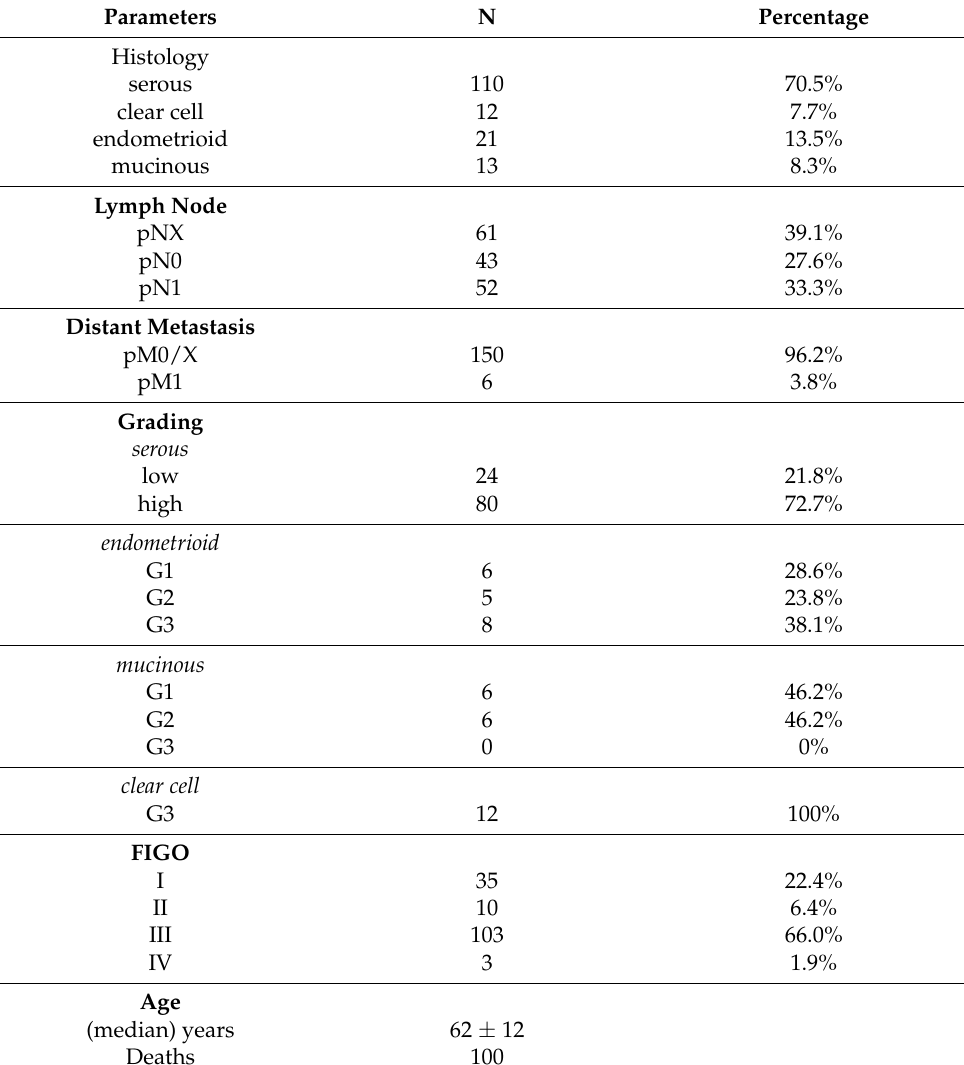
Table 1. Patient